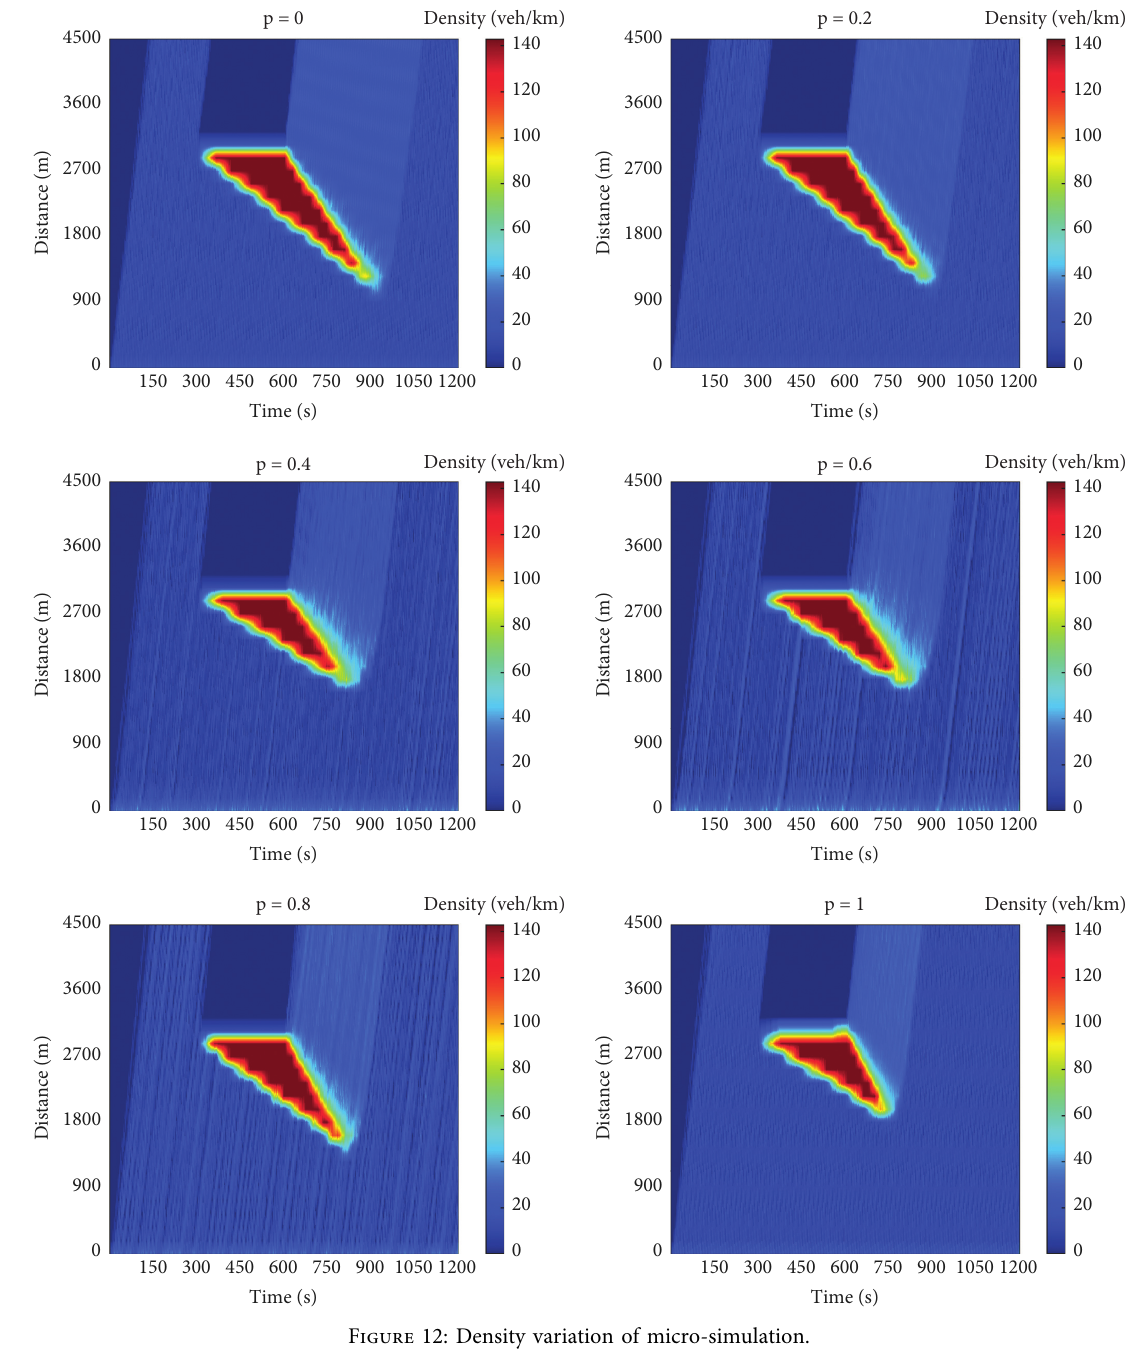
Figure 12: Density variation of micro-simulation.